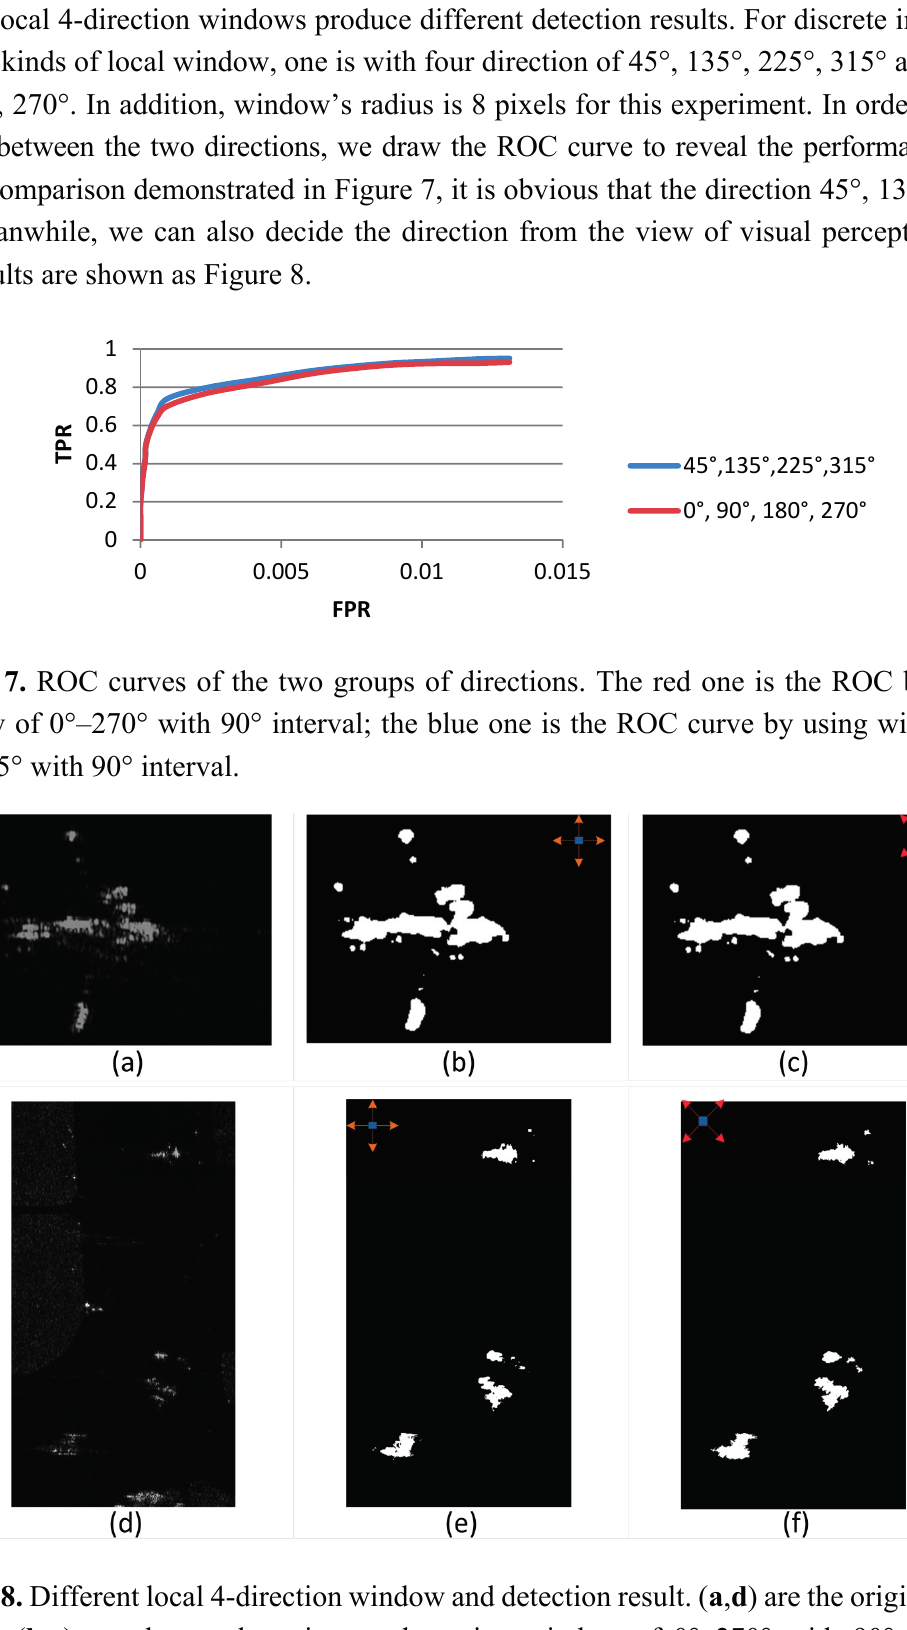
Figure 8. Different local 4-direction window and detection result. ( a , d ) are the original SAR images; ( b , e ) are the resultant images by using window of 0°–270° with 90° interval; ( c , f ) are the resultant images by using window of 45°–315° with 90°